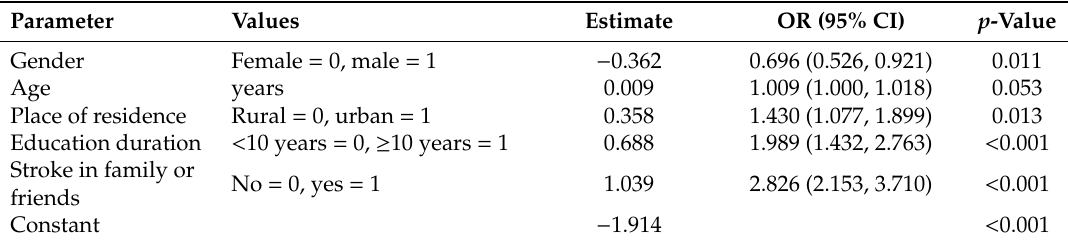
Table 7. Multivariate stepwise binary logistic regression model to identify independent predictors of adequate knowledge of